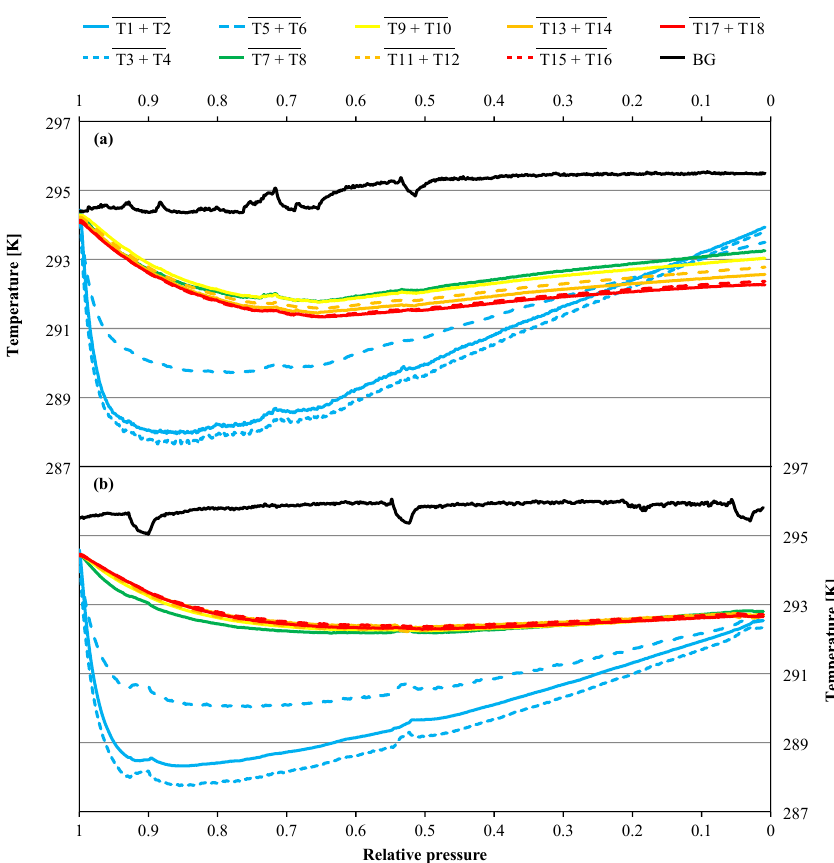
Figure 10. Temperature measurements against relative pressure; note the inverse x axis. Because the initial pressures of the two cylinders were slightly different (CB11873 at 140.0bar and CB12009 at 128.2bar), the pressure is expressed as relative pressure ( P/P 0 ) in order to use the same x axes for both panels. The measurements in panel (a) come from a high-flow experiment with a vertically positioned cylinder (CB11873 on 4 May 2017); the temperatures in panel (b) were measured during a high-flow experiment with a horizontally positioned cylinder (CB12009 on 8 May 2017). The lines represent averages of the following thermistors. Pressure regulator to stem: solid blue, T1 and T2; dotted blue, T3 and T4; dashed blue, T5 and T6. Cylinder valve: green, T7 and T8. Cylinder body: yellow, T9 and T10; dashed orange, T11 and T12; solid orange, T13 and T14; dashed red, T15 and T16; solid red, T17 and T18. Laboratory background: black, T19 to